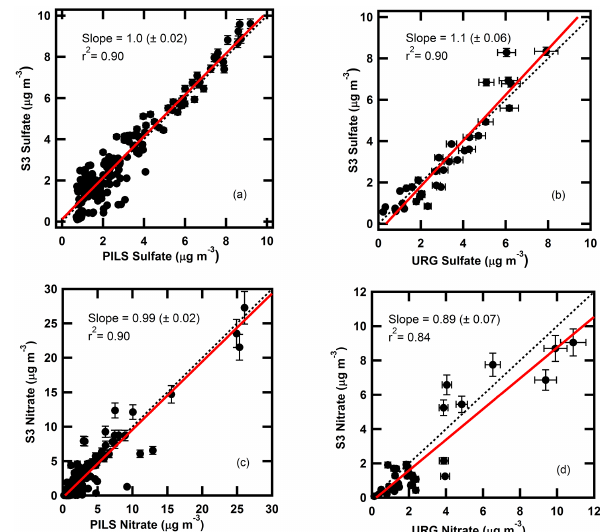
Figure 6. Comparison of aerosol nitrate and sulfate during the San Gorgonio, CA study between the S3, PILS-IC, and URG systems. The top panel (a, b) is a comparison of sulfate between the averaged data from the two S3 samplers and PILS and URG, respectively, and the bottom panel (c, d) presents the same comparison for nitrate. The dashed lines are the 1 : 1 line; the solid red lines are the corre- lation between the data presented. The error bars show the pooled %RSDs for the two S3 systems used in this study, and the error bars for the URG systems were taken from collocated observations reported by Yu et al.